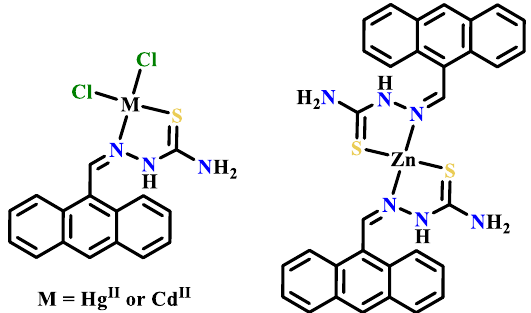
Figure 14. Zinc(II), cadmium(II), and mercury(II) complexes based on novel anthrahydrazone lig- and with thiourea side chain.